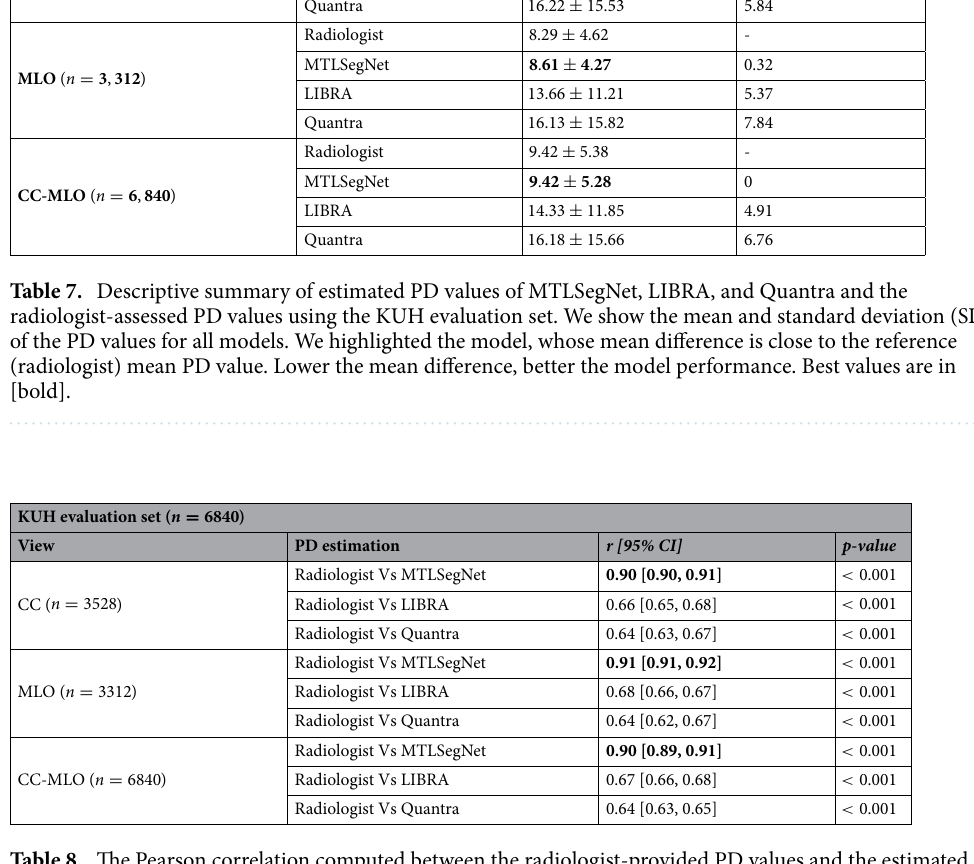
Table 8. The Pearson correlation computed between the radiologist-provided PD values and the estimated PD values from MTLSegNet, LIBRA, and Quantra at 95% CIs on the log-transformed PD values. The models with high correlation are highlighted. For both CC- and MLO-view mammograms, our proposed approach demonstrated a strong correlation with the radiologist-provided density values. Best values are in [bold].